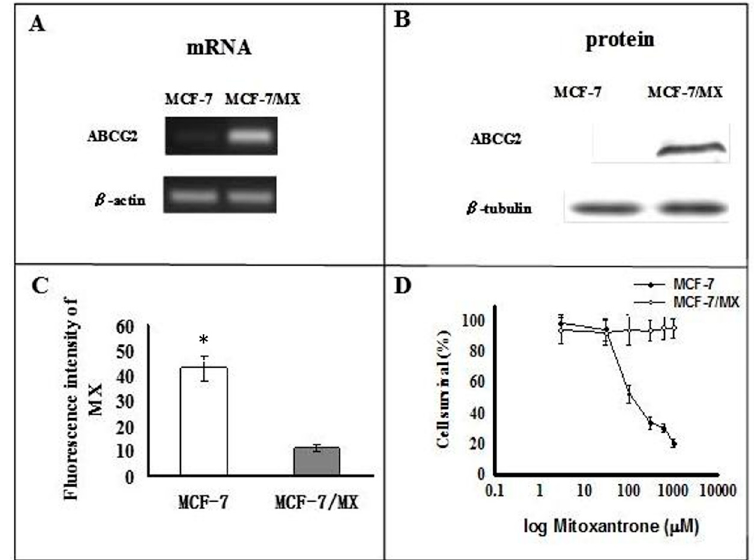
Figure 1. MX resistance and over-expression of ABCG2 in MCF-7/MX cells. Level of ( A ) mRNA and ( B ) protein of ABCG2 in MCF-7 and MCF-7/MX cell lines; ( C ) Retention of MX in MCF-7 cells and MCF-7/MX cells. Fluorescence was measured using the FacsCalibur flow cytometer (Becton–Dickinson, Mountain View, CA, USA) ( n = 4). (* p < 0.001); ( D ) Chemosensitivity of MCF-7 and MCF-7/MX cells